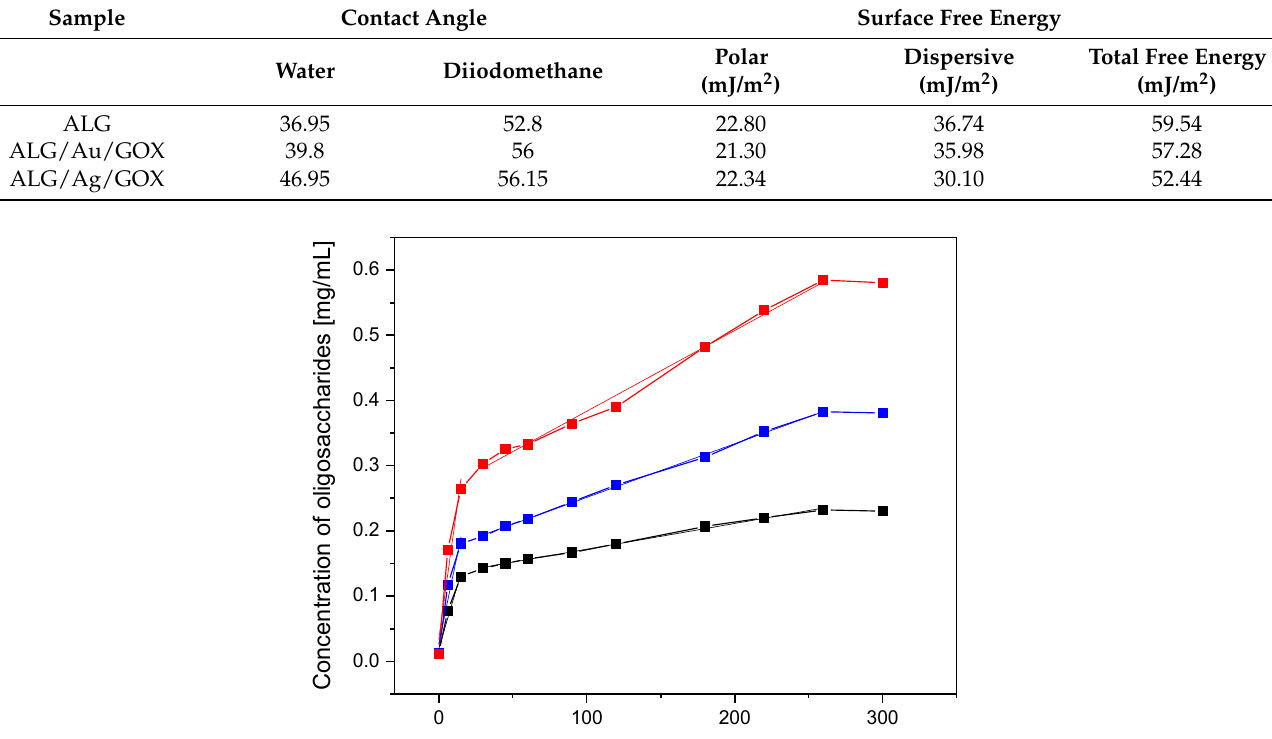
Figure 8. Graph showing the relationship between the reaction time and reducing sugar concentration of: ALG (black line), ALG/Ag/GOX (blue line), ALG/Au/GOX (red line). The reaction efficiency (Table 3) of hydrolysis was calculated using Equation (1): W = (GD/GT)·100% (1) where W denotes the reaction efficiency, GD is the amount of oligosaccharides received in the reaction, and GT is the theoretical amount of oligosaccharides resulting from the reaction equation. Table 3. Values of rate constants (k) and hydrolysis yields (W). Sample